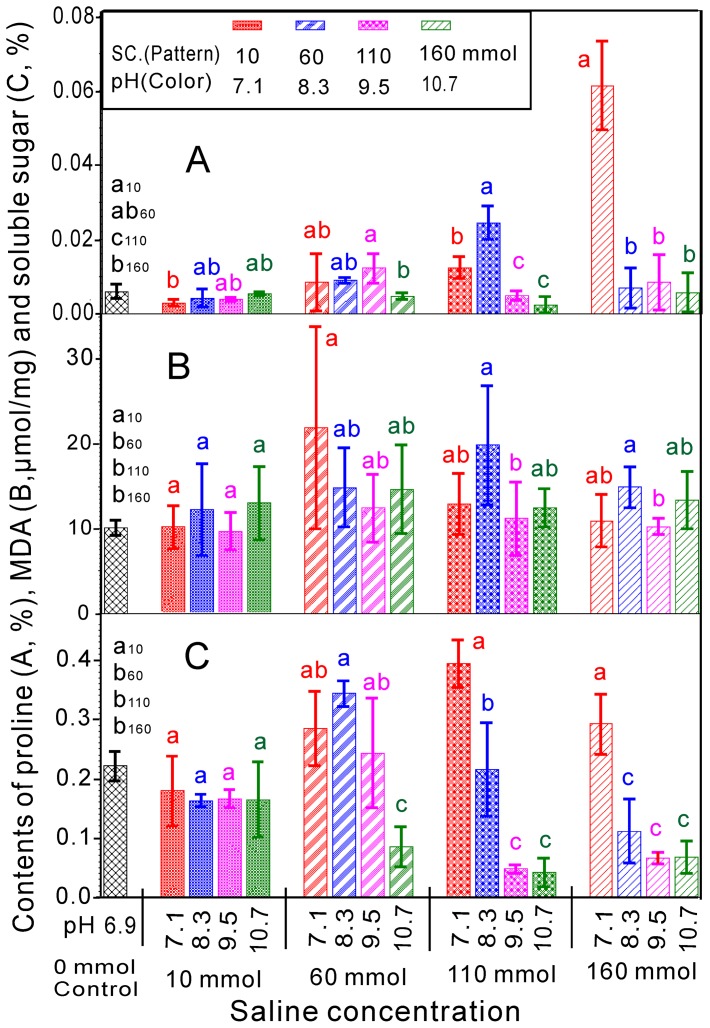
Contents of proline (A, %), MDA (B,μmol/mg) and soluble sugar (C, %) in switchgrass under salinity and alkali mixed stresses.The saline concentrations were separately compared with the control in each group. The letters indicate differences at P<0.05 within the groups.